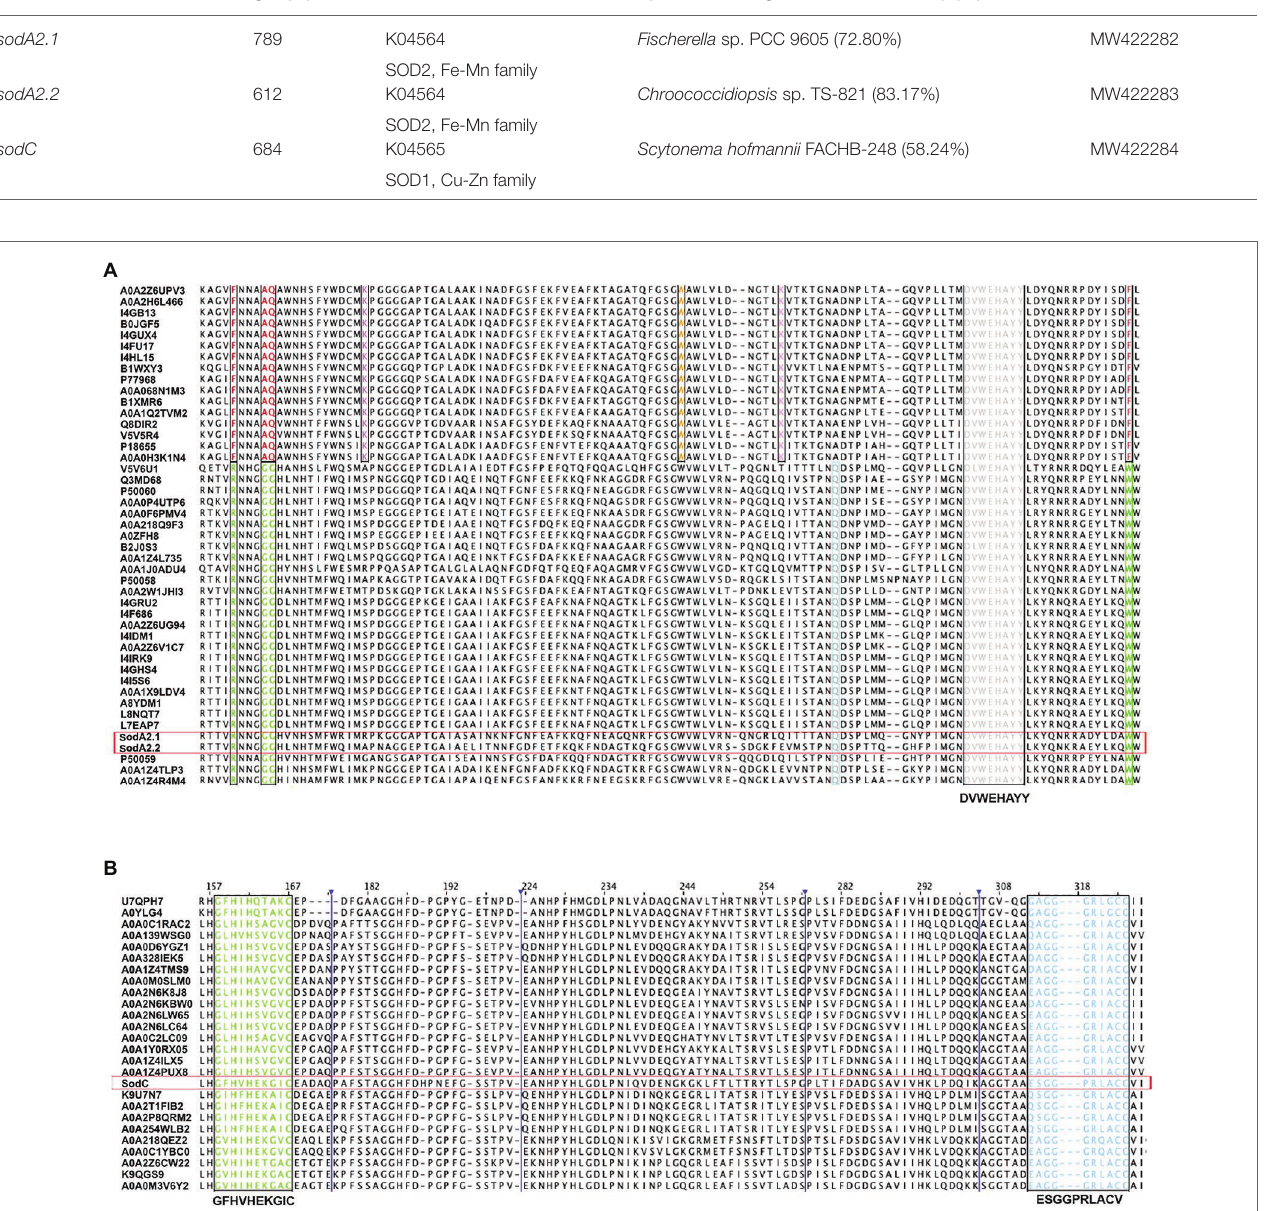
FIGURE 1 | Multiple alignment of superoxide dismutases (SODs) from Chroococcidiopsis sp. CCMEE 029. (A) First quartile sequence of MnSODs (SodA2.1 and SodA2.2) and cyanobacterial Fe/MnSOD. Metal-binding motif DVWEHAYY is highlighted in gray. Highly conserved metal specific residues are highlighted in green for MnSODs and in red for FeDODs. Residues involved in outer sphere hydrogen bonding are highlighted in cyan for MnSODs and for FeSODs in orange. Lys (K) residue of FeSODs involved in photosynthetic context is boxed in pink. (B) Multiple alignments of half sequence of CuZnSod (SodC) and cyanobacterial CuZnSods. The copper domain G-F-H-[ILV]-H-x-[NGT]-[GPDA]-[SQK]-C is highlighted in green and the conserved motif G-[GA]-G-G-[AEG]-R-[FIL]-[AG]-C-G is in blue. The list of UniProt entries was provided in the Supplementary Tables S1 , S2